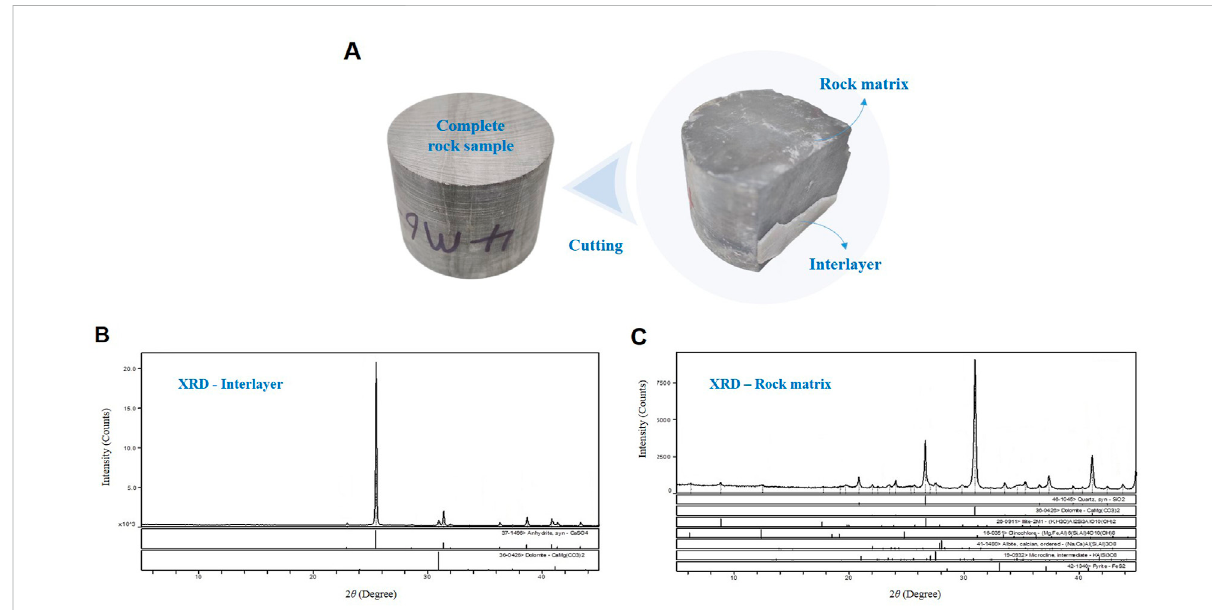
FIGURE 1 XRD pattern for the dolomite with the interlayer (A) Schematic diagram of rock matrix and interlayer (B) XRD pattern for interlayer (C) XRD pattern for rock